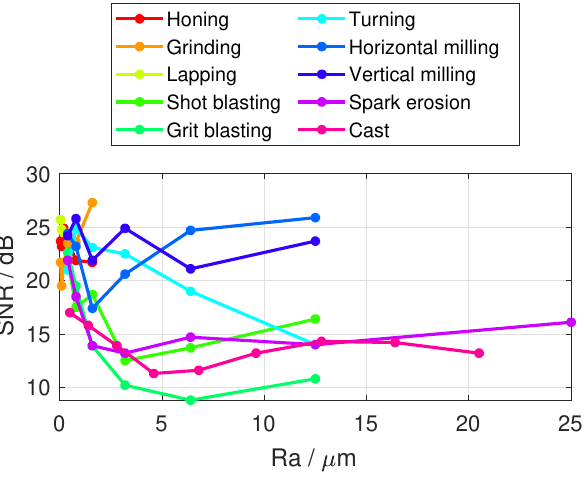
Figure 5. Surface roughness versus SNR; the R a does not generally correlate with the SNR obtained.